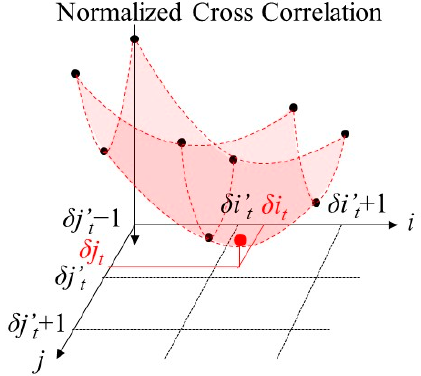
Figure 2. Outline of parabola fitting with 8 peripheral pixels.